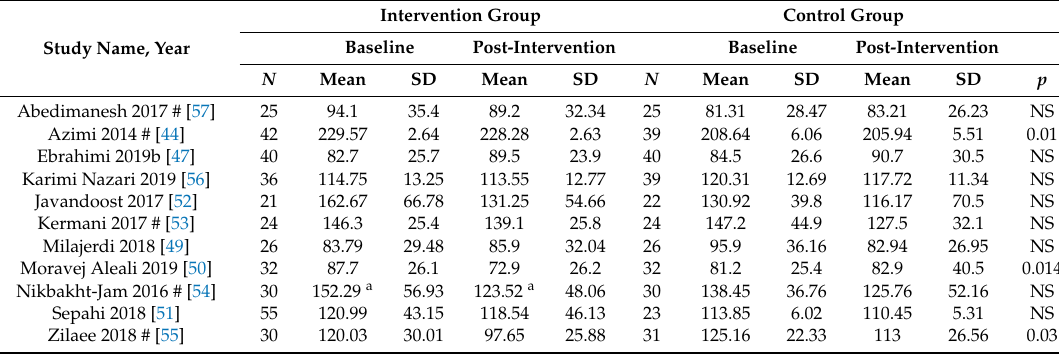
Table 5. Summary of findings for LDL cholesterol (LDL-c).